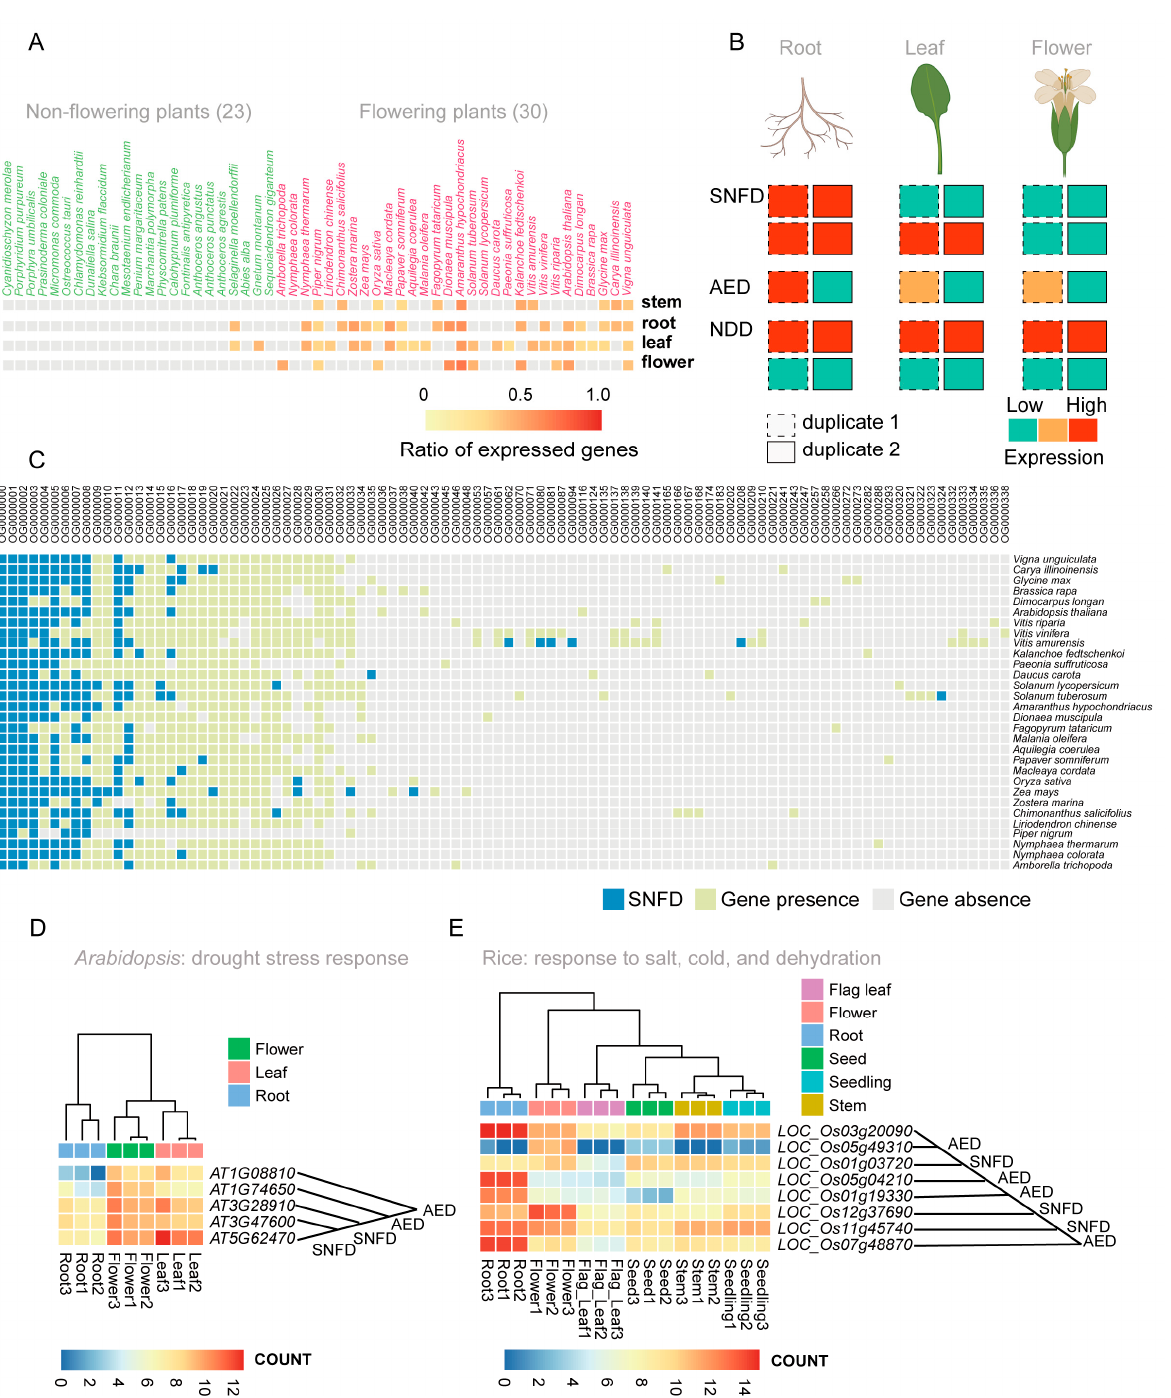
Figure 5. Neo-/sub-functionalization of MYB gene duplicates. ( A ) Heatmap of MYB gene expression ratios (i.e., the number of expressed MYB genes/total number of MYB genes) in root, stem, leaf, and flower of 53 selected plant species. Flowering and non-flowering plants were labeled with red and green color, respectively. Red color in heatmap indicates a high ratio, yellow indicates a low ratio, and grey indicates no published RNA-seq data. ( B ) Illustration of different expression patterns in multiple plant tissues, indicating sub-/neo-functionalized duplicates (SNFD), asymmetrically expressed duplicates (AED), and the remaining “no difference” duplicates (NDD). For the definition, SNFD indicates each gene in the duplicate pair was significantly more highly expressed than the other in at least one tissue; AEDs indicates one duplicate was significantly more highly expressed than its paralog in at least 1/3 of tissues, and its expression was not lower than its paraplog in the other